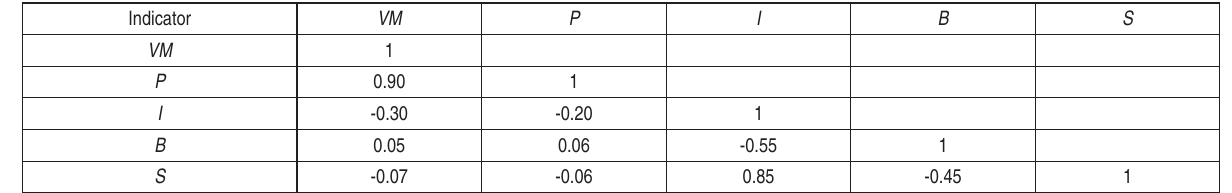
Table 6. Matrix of coefficients of pair correlation to calculate the volume of loans given by foreign economic